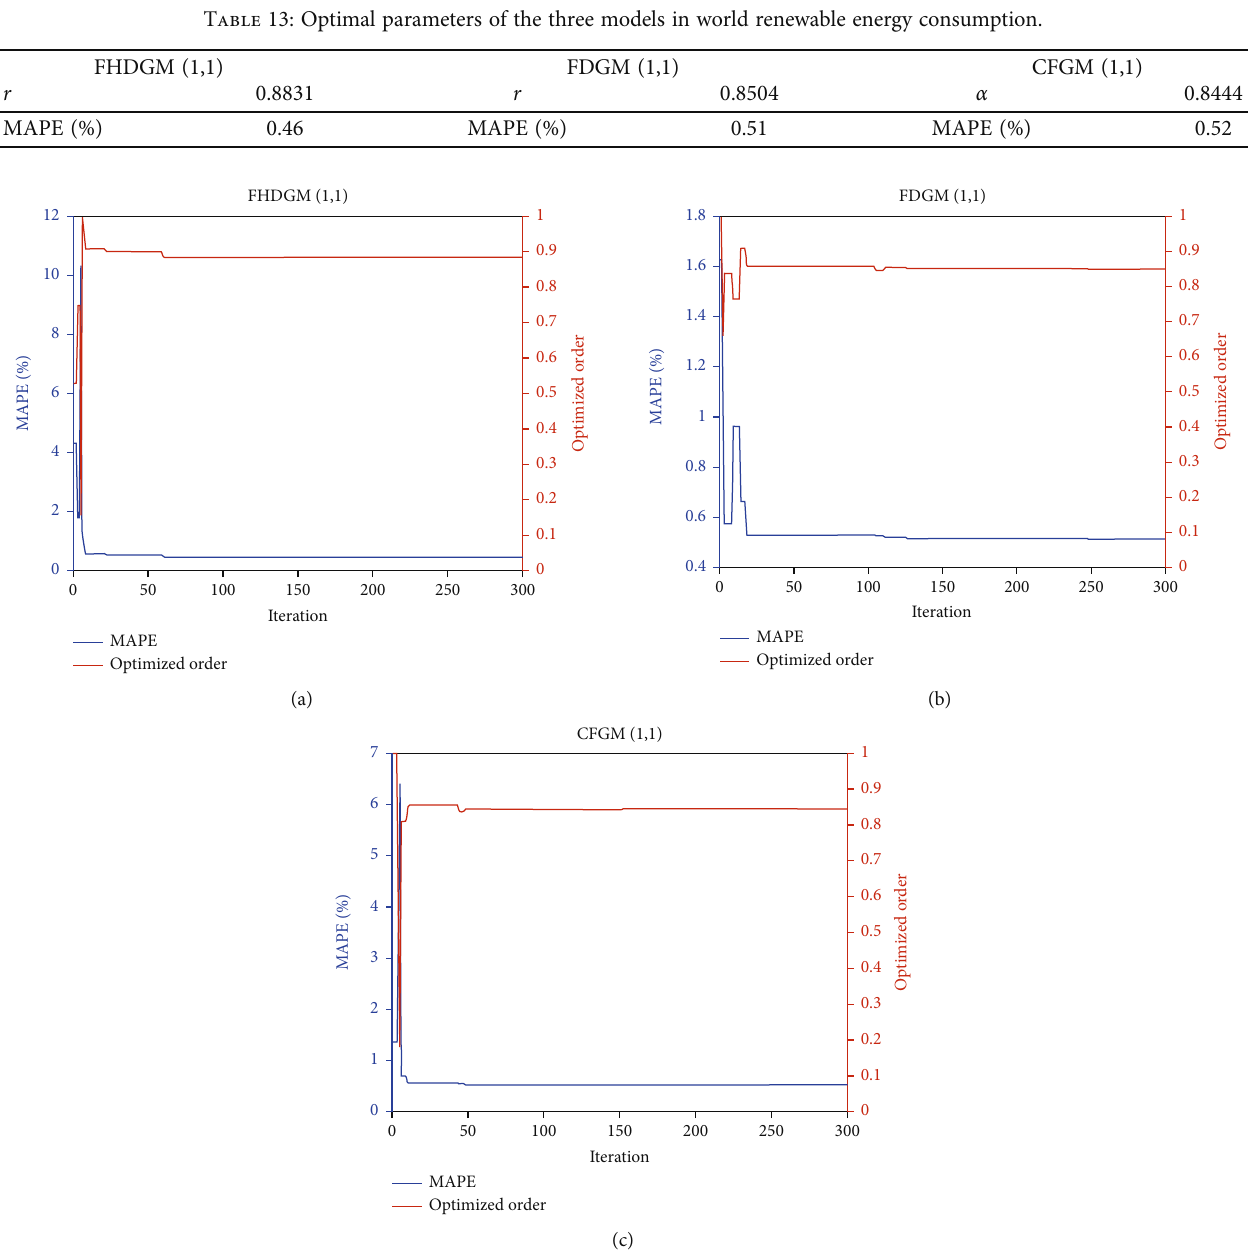
Figure 9: Track of searching for the minimum MAPE and the optimal parameter. Table 14: The expression of four grey